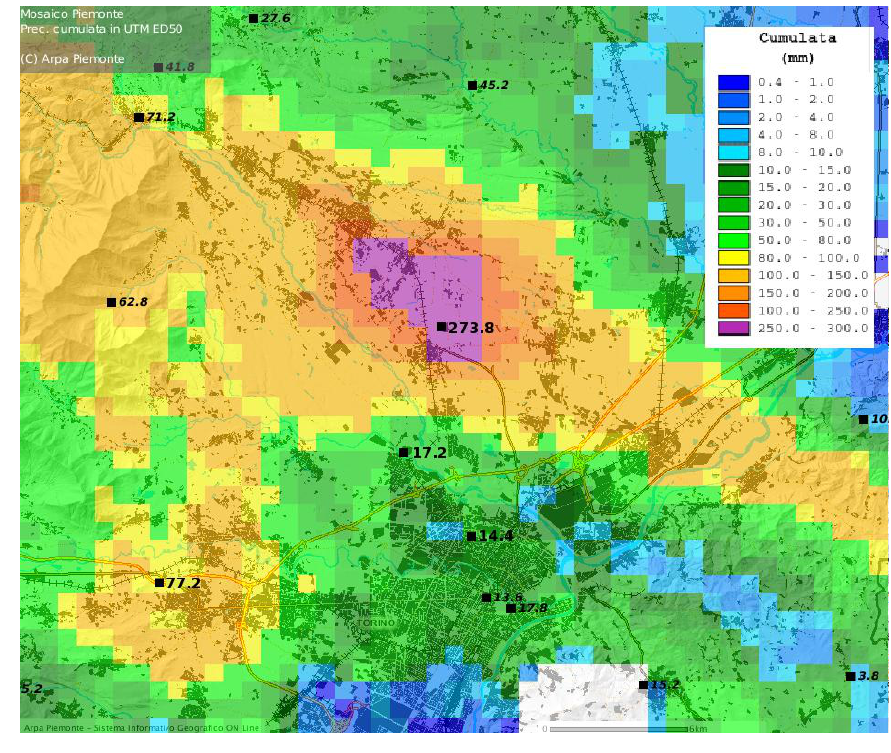
Figure 4. Accumulated precipitation estimated by radar (colour) and measured by regional raingauges since 06:00 to 18:00 UTC on 13 September